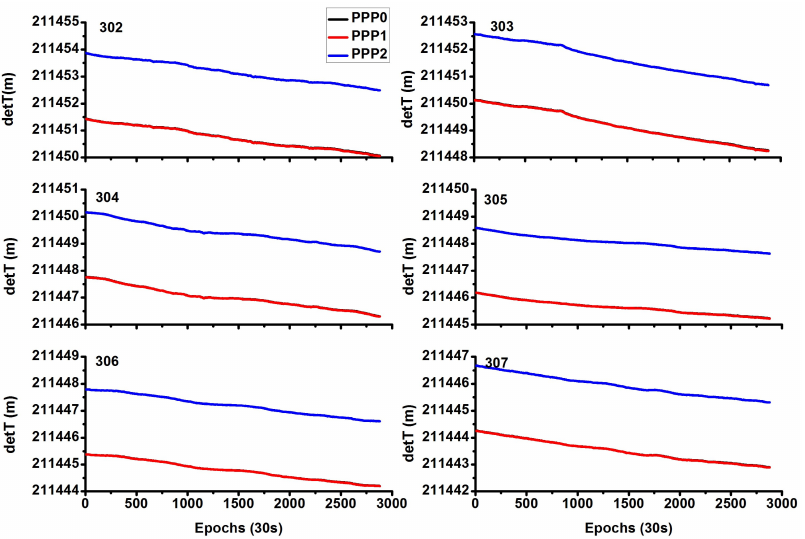
Figure 11. Comparison of time difference between different models by stations CEDU ( left side) and KAT1 ( right